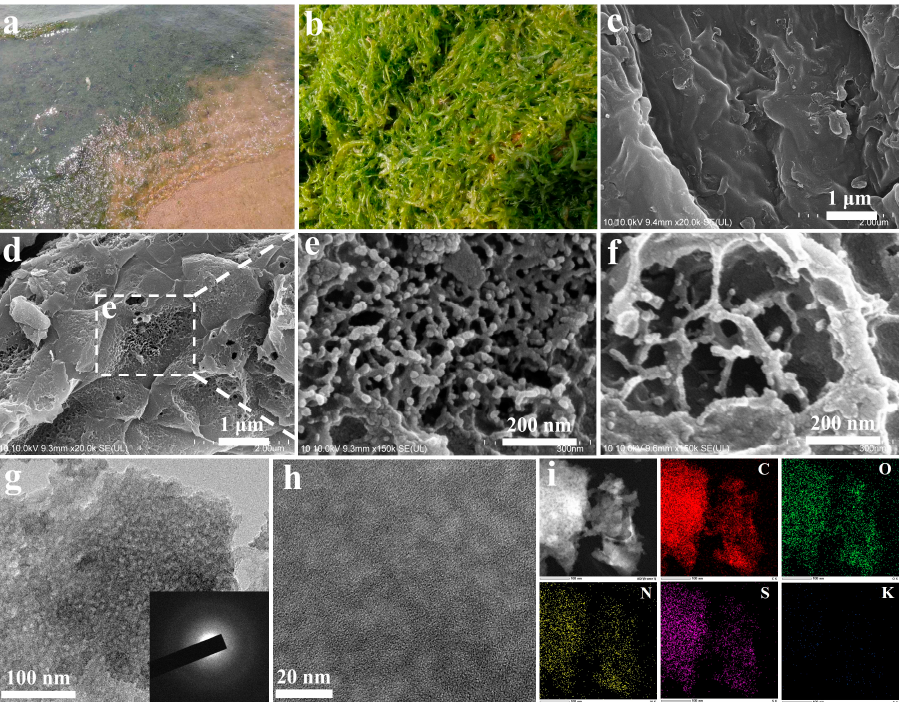
Figure 1. The photographs of ( a ) an EP invaded seashore at Tsingtao City, Shandong Province of China, and ( b ) the fresh EP biomass. The SEM images of ( c ) fresh EP, ( d , e ) EBC-K, and ( f ) EBC-Na. The TEM images with ( g ) low and ( h ) high magnification of EBC-K; the inset is the SAED image. ( i ) HAADF-STEM image and EDS element distribution of EBC-K (red: carbon, green: oxygen, yellow: nitrogen, magenta: sulfur and blue: potassium).